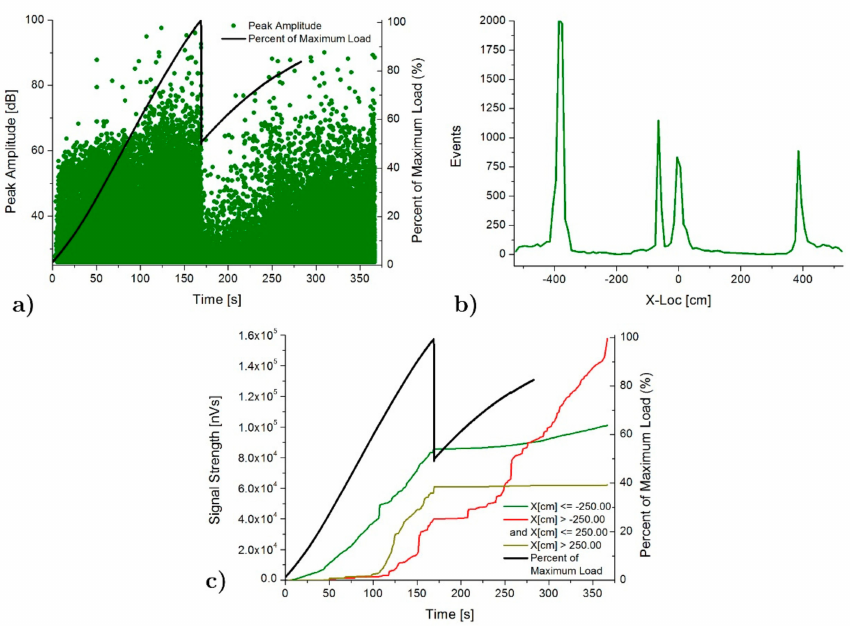
Figure 10. AE results for SFB specimen: ( a ) Peak amplitude vs load history over the time, ( b ) Linear location over the specimen and ( c ) Signal strength vs load history over the